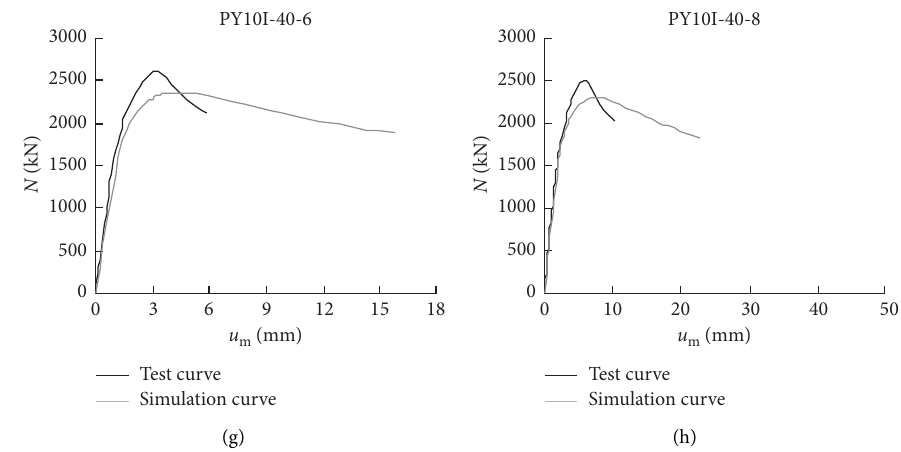
Figure 8: Comparisons between the calculated and tested results.